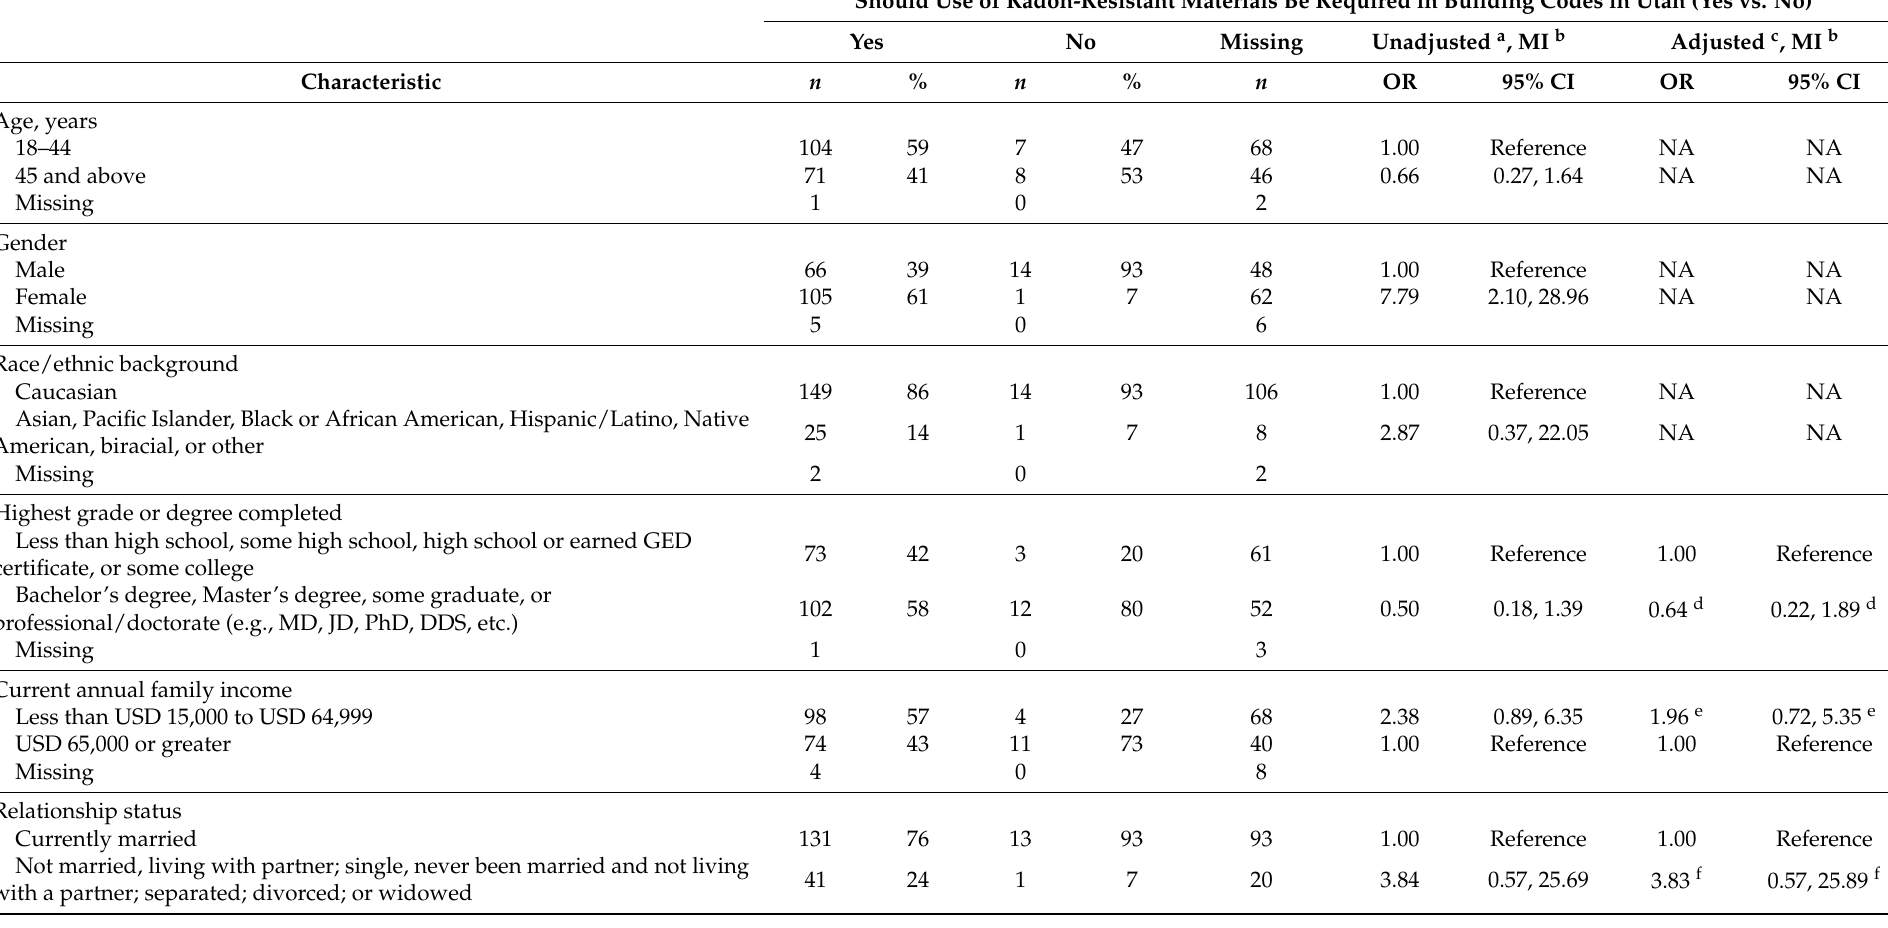
Table 6. Unadjusted and adjusted, multiply imputed associations between characteristics and opinions regarding whether use of radon-resistant materials should be required in building codes in Utah among radon testing survey participants, Utah County, Utah, May 2014–January 2016. Should Use of Radon-Resistant Materials Be Required in Building Codes in Utah (Yes vs.